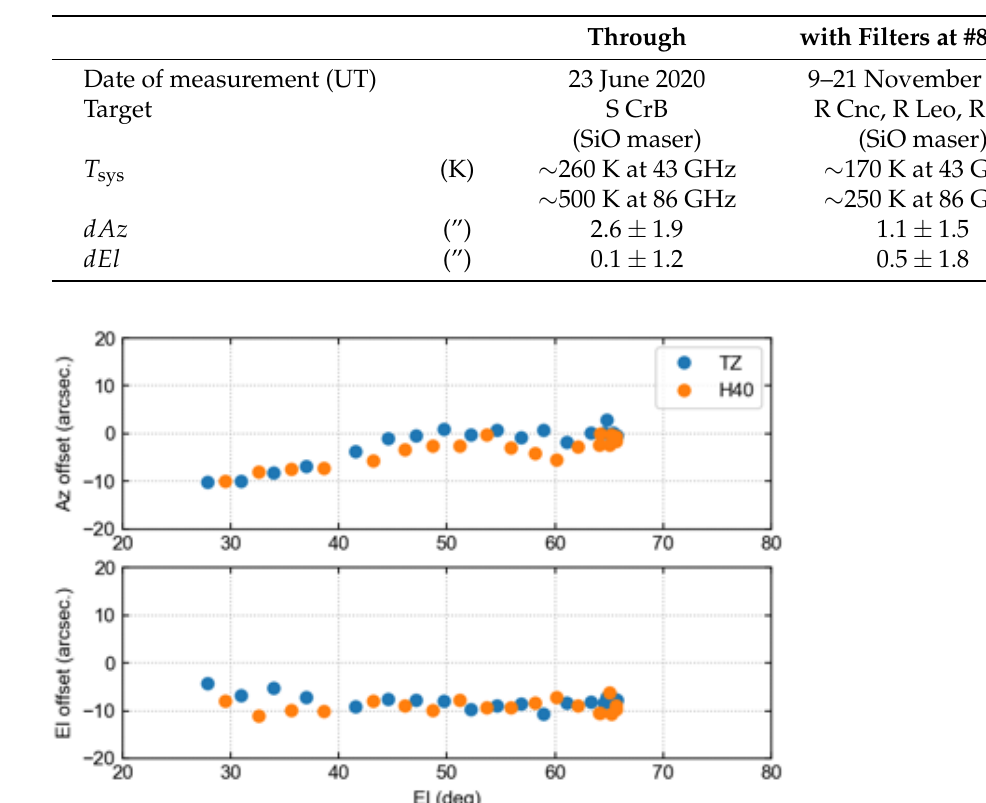
Figure 6. Variation in the pointing offset against the elevation between the H40 (43 GHz) and TZ (86 GHz) receiving systems after removal of the beam squint